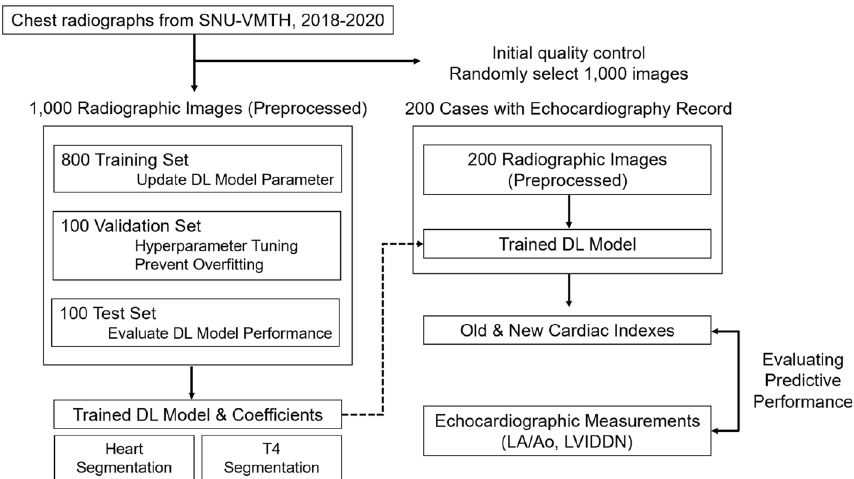
Figure 1. An overall process of developing a new cardiac index of adjusted heart volume index (aHVI). After the quality check, one thousand images were randomly divided into 800 training, 100 validation, and 100 test sets to develop a deep learning model. In the training stage, segmentation, measurements, and optimization were conducted. The performance of aHVI from the trained model was compared with the VHS (vertebral heart score, the current standard, manual measure) against the echocardiographic measurement of cardiomegaly (combined LA/Ao and LVIDDN) using 200 independent